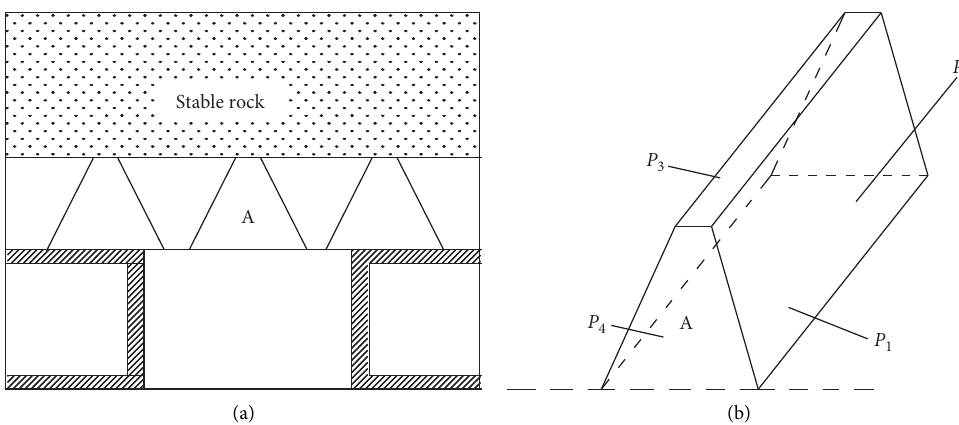
Figure 2: Hexahedron block structure of the roof of a roadway.